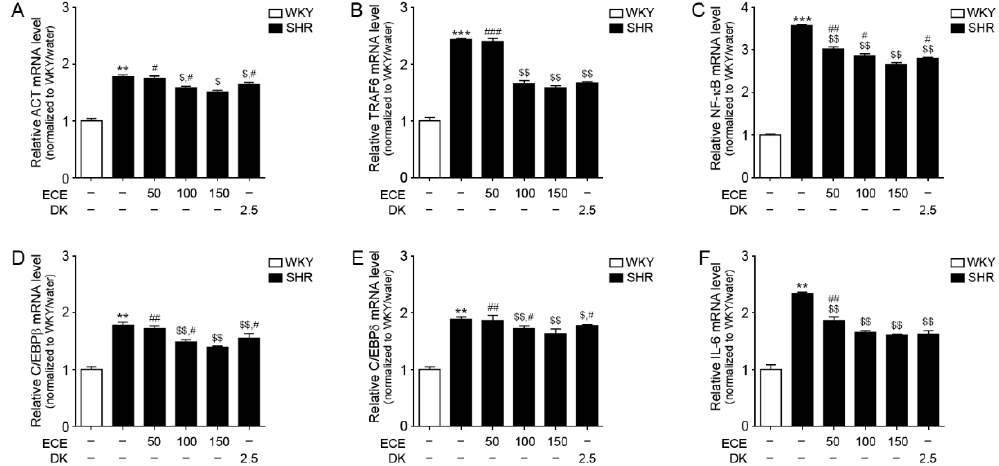
Figure 4. Modulating effects of DK and ECE on the IL-17A/NF- κ B/IL-6 pathway in the aorta of SHRs. ( A – F ) In aorta tissue, ( A ) ACT, ( B ) TRAF6, ( C ) NF- κB, ( D ) C/EBPβ, ( E ) C/EBPδ, and ( F ) IL-6 mRNA levels were increased by SHR/water. The addition of ECE and DK decreased the ACT, TRAF6, NF- κ B, C/EBP β , C/EBP δ , and IL-6 mRNA levels. For each of the 6 groups, n = 5. **, p < 0.01 and ***, p < 0.001 vs. WKY/water; $, p < 0.05 and $$, p < 0.01, vs. SHR/water; #, p < 0.05 and ##, p < 0.01, vs. SHR/ECE150 (Mann–Whitney U test). ACT, NF- κ B activator1; C/EBP β , CCAAT/enhancer-binding protein beta; C/EBP δ , CCAAT/enhancer-binding protein delta; DK, dieckol; ECE, Ecklonia cava extract; IL-6, interleukin-6; NF- κ B, nuclear factor kappa B; SHR, spontaneously hypertensive rat; TRAF6, tumor necrosis factor receptor-associated factor 6; WKY, Wistar Kyoto